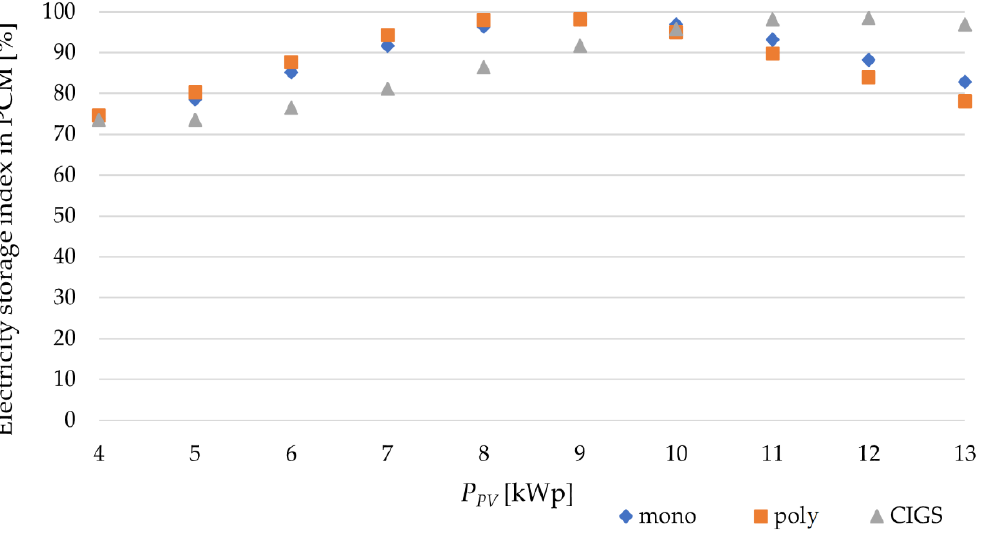
Figure 15. Electricity storage index in PCM as a function of PV power plant power—sunny days.